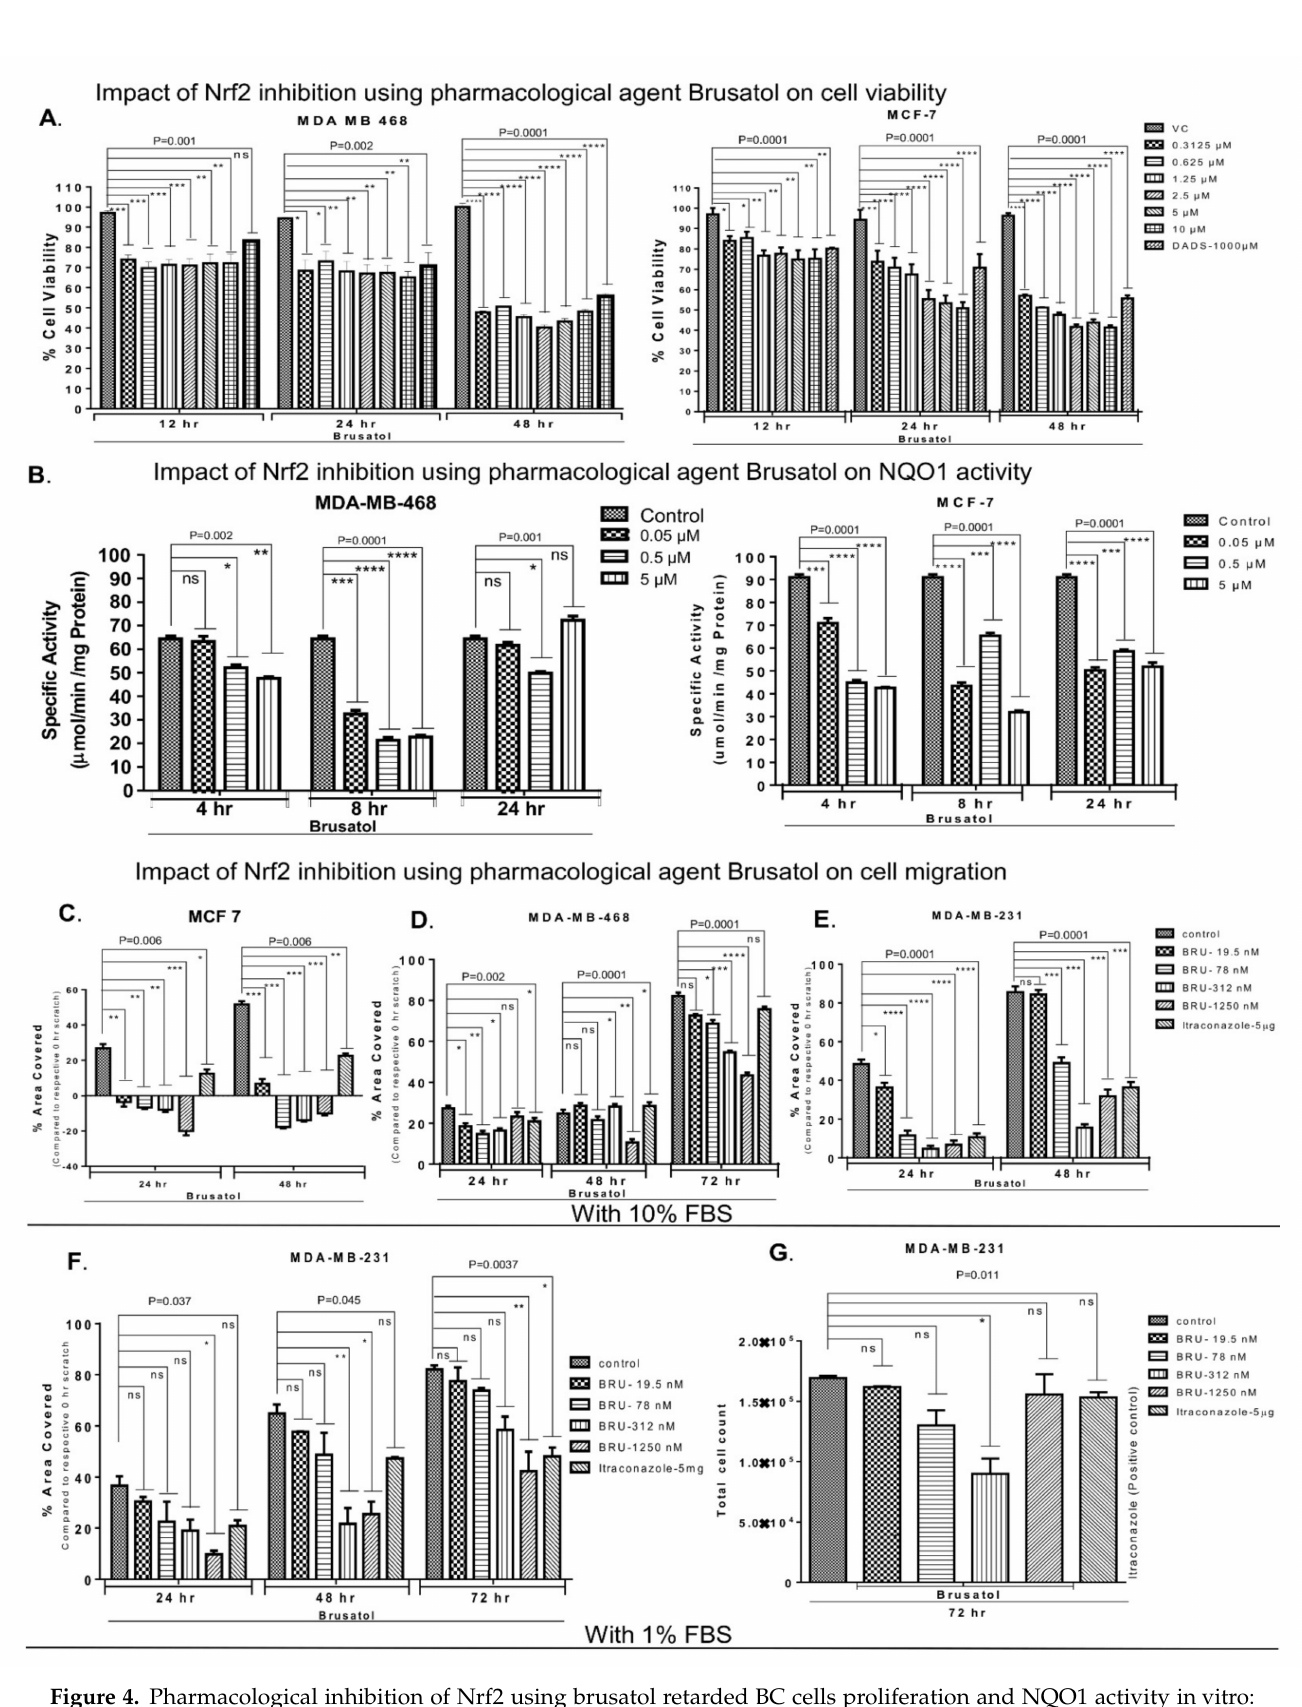
Figure 4. Pharmacological inhibition of Nrf2 using brusatol retarded BC cells proliferation and NQO1 activity in vitro: ( A ) cell viability was measured using SRB assay. Brusatol (concentration range from 0.3125 to 10 µ M) was used as chemical inhibitor of Nrf2 [37,70]. MDA-MB-468 and MCF-7 cells were exposed to increasing concentrations of brusatol for 12, 24,